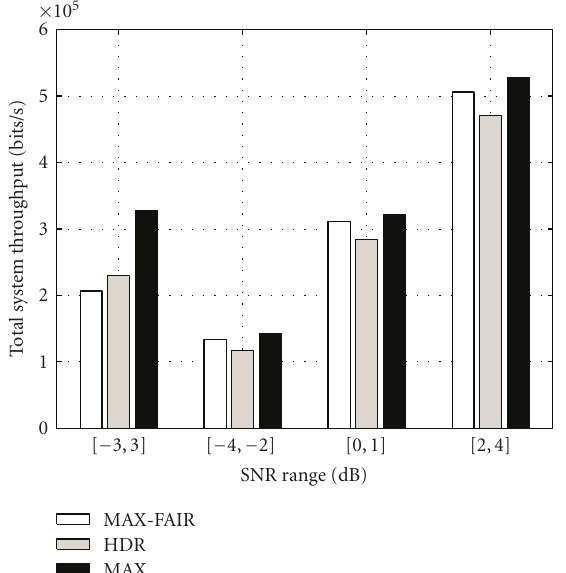
Figure 6: Achieved system throughput under di ff erent SNR ranges.